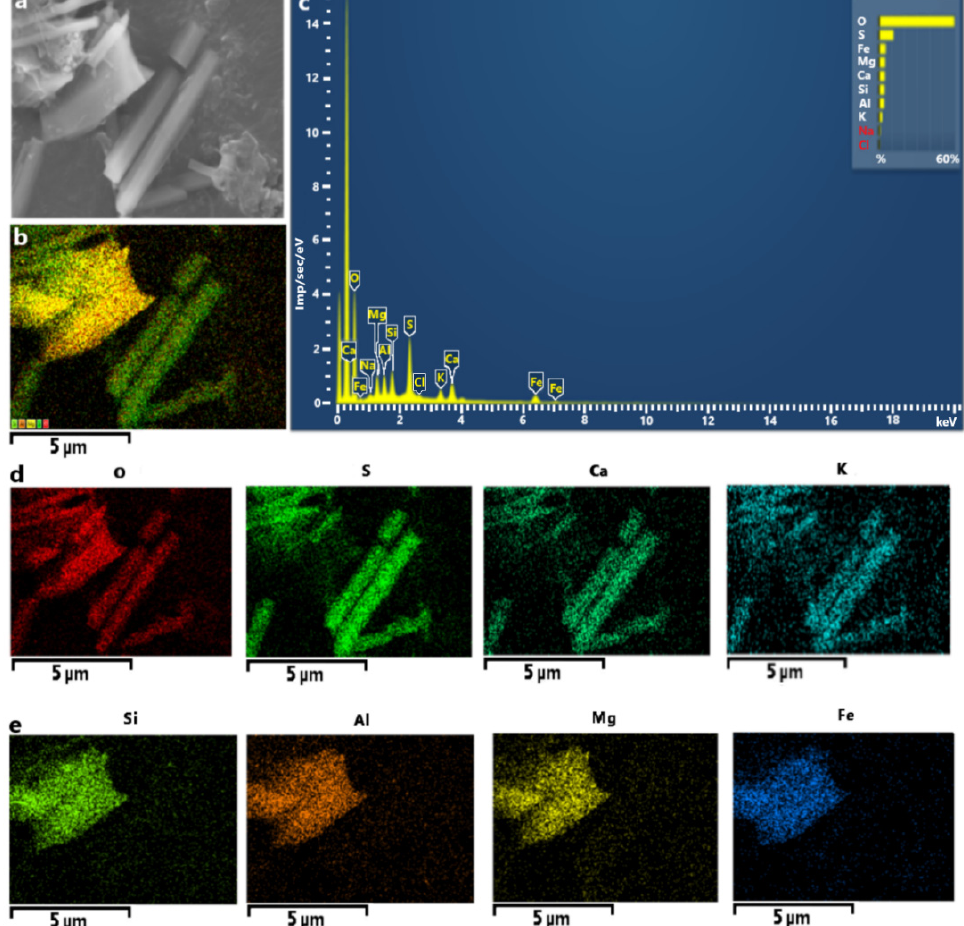
Figure 4. ( a ) SEM micrograph (magnification 500 × ), ( b ) chemical mapping of the most abundant elements, and ( c ) EDS spectrum of aggregate particles from the aluminosilicate group ( d ), maps rod-like particles consisting of K, Ca, S, and O that could be potassium and calcium sulfates ( e ), and plates consisting of Fe-Mg-enriched aluminosilicates.